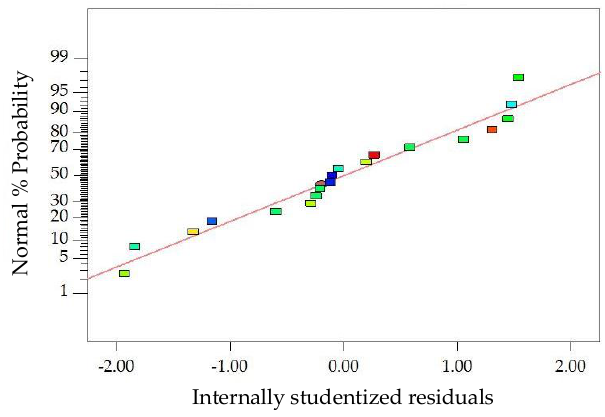
Figure 12. Diagnostics of statistical model: normal plot of residuals for VMA .